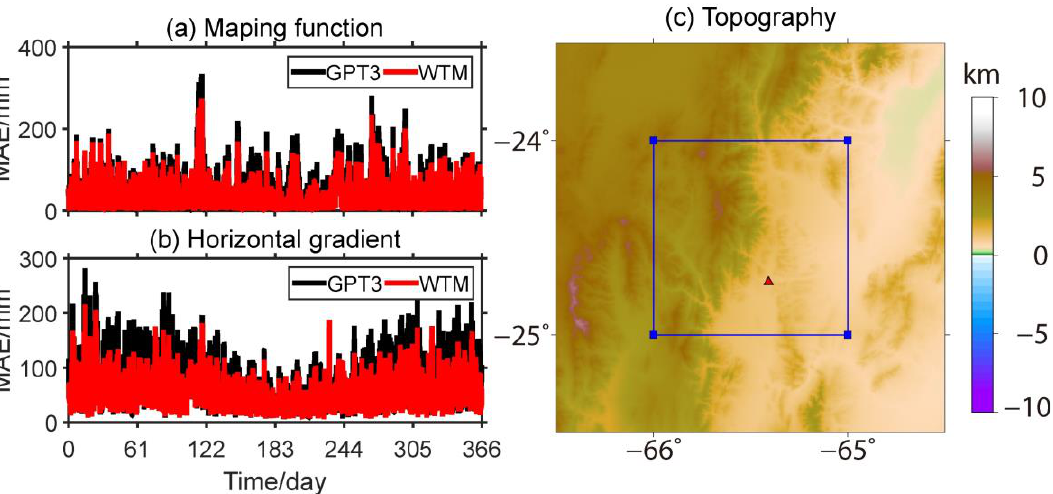
Figure 7. Mapping function ( a ) and horizontal gradient ( b ) MAE time series as well as surrounding topography ( c ) of the UNSA station. The red triangle represents the station location. The blue grid denotes the 1° × 1° grid of the GPT3 model.